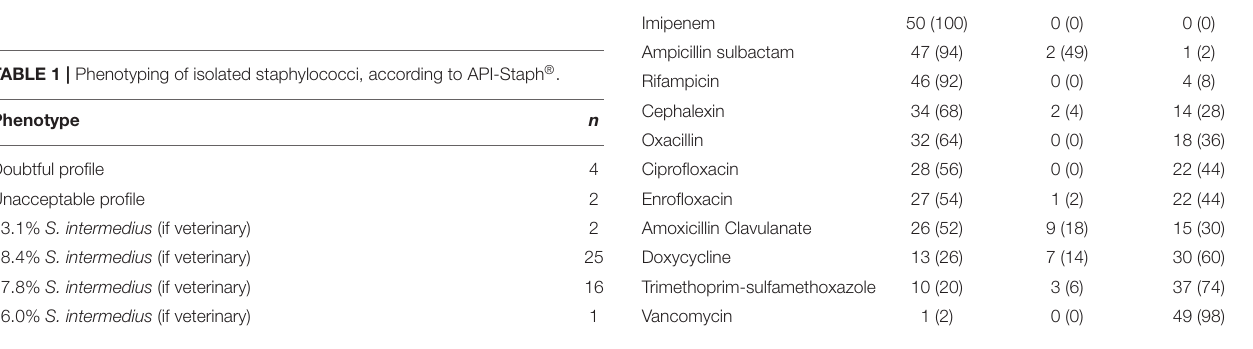
TABLE 2 | Antimicrobial sensitivity test for the isolates of Staphylococcus species. Antimicrobial